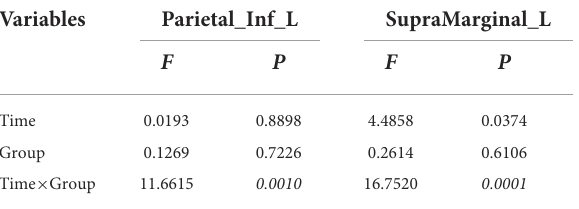
TABLE 6 Repeated measures ANCOVA of TRD and HC at baseline and post taVNS stimulation period. Variables